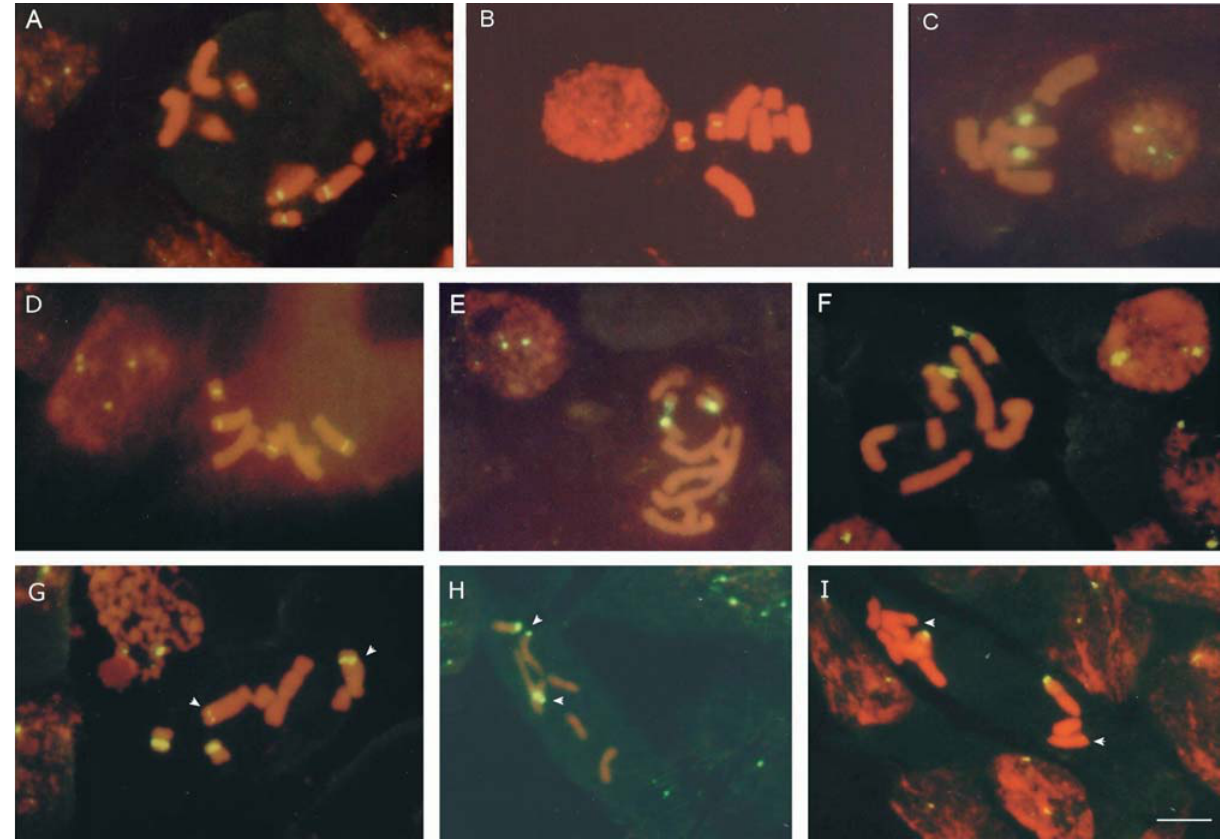
Figure 1 - Hybridization signals of mitotic metaphases probed with 45S rDNA genes in Hypochaeris species: (A) H. brasiliensis , (B) H. grisebashii , (C) H. megapotamica , (D) H. microcephala , (E) H. pampasica , (F) H. rosengurtii , (G) H. variegata (arrows = size polymorphism of 45S rDNA on chromo- some pair 2), (H) H. glabra , and (I) Hypochaeris sp (arrows = weak 45S hybridization signals on chromosome 4) Bar = 6 µ